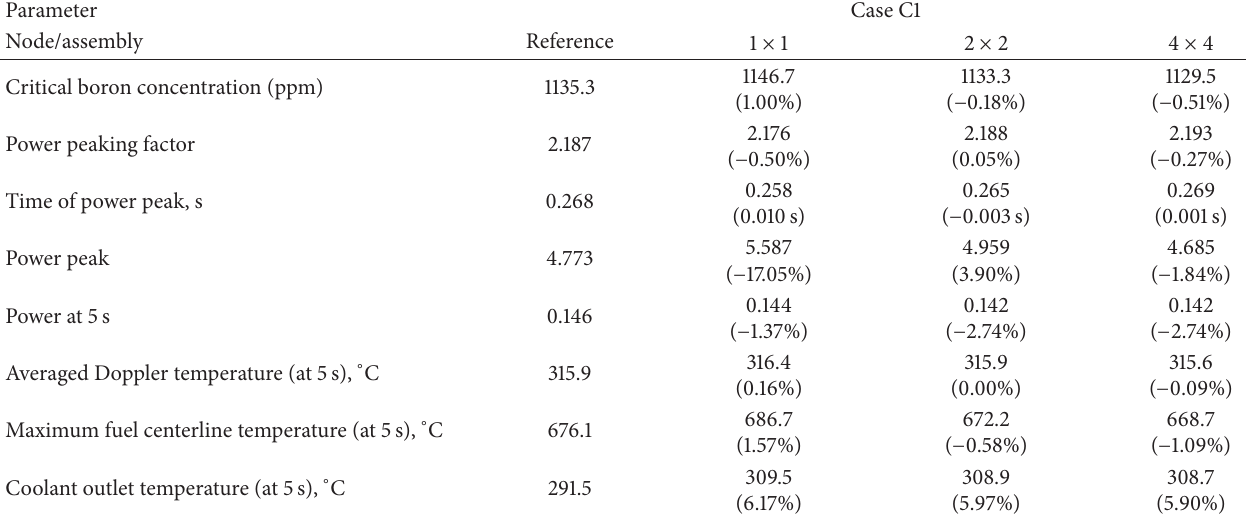
Table 2: Sensitivity analysis results in the radial node number per assembly for case